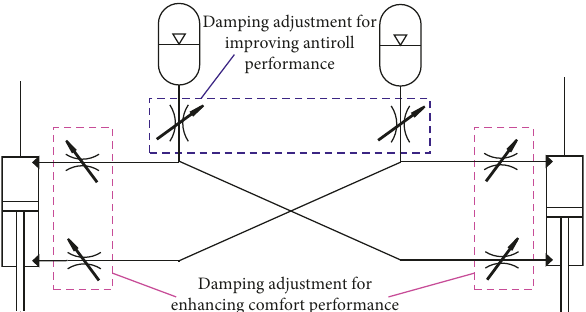
Figure 9: Novel semiactive control system based on HIS